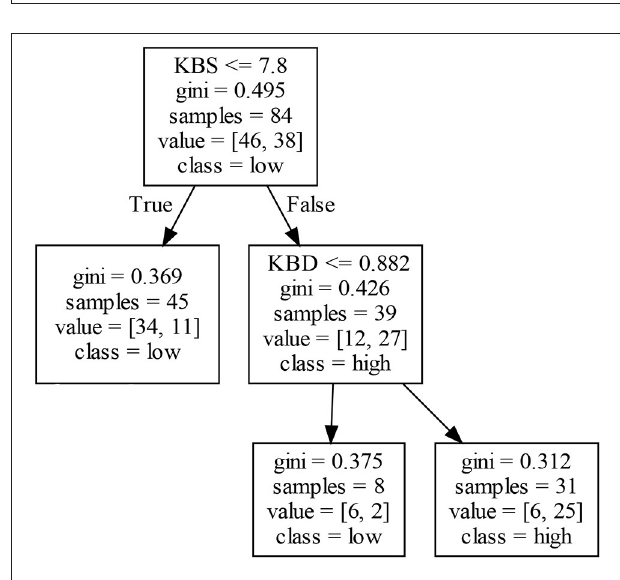
FIGURE 7 | Decision tree for EIP2 in Cluster III.